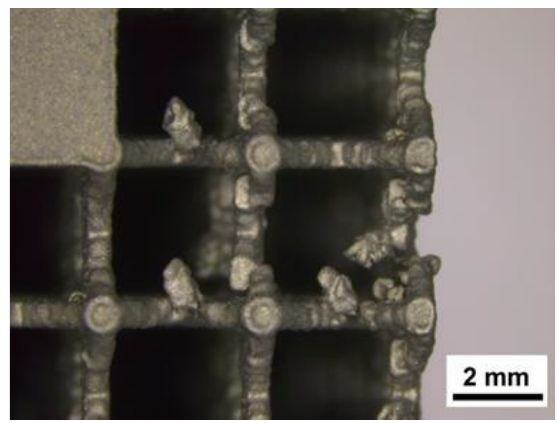
Figure 2. Defects observed in test